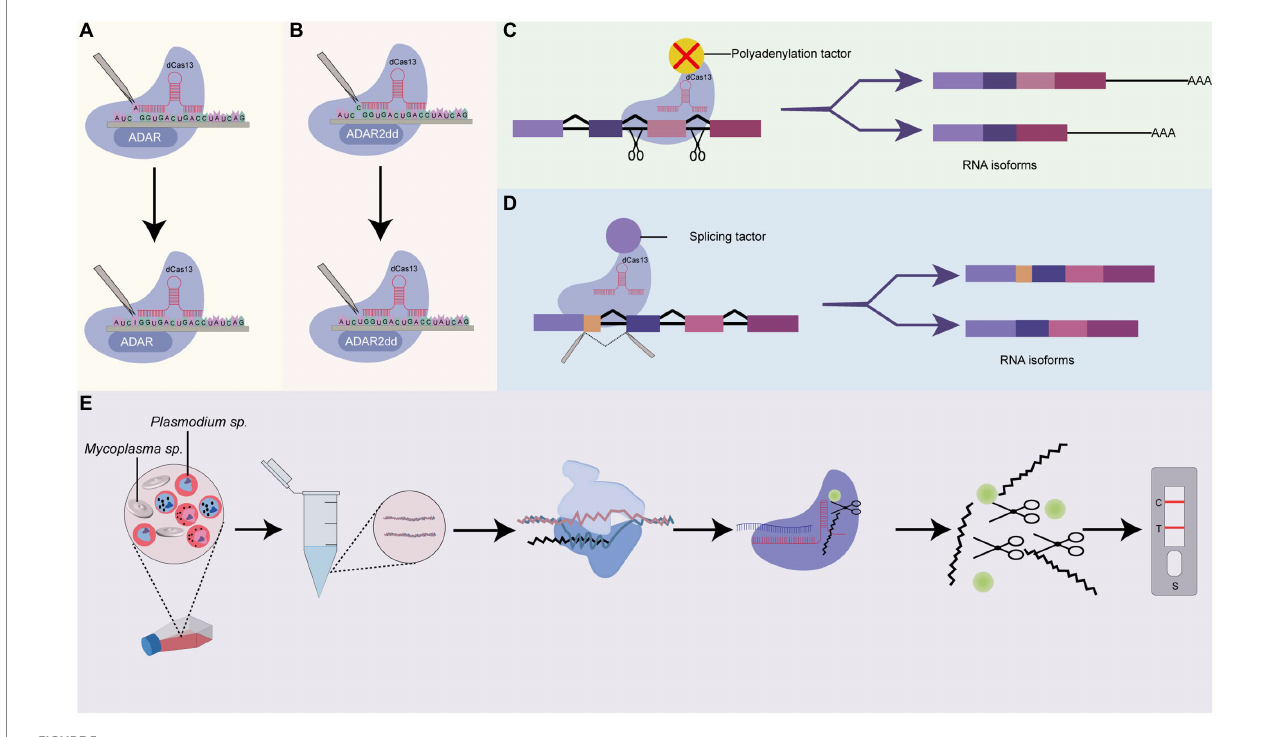
FIGURE 5 Prospects of Cas13-base systems for RNA editing in Plasmodium . (A) dCas13 tethered to ADARs for a single-nucleotide base editing in RNA. This system uses dCas13 effector-deaminase acting on RNAs (ADARs) domains fusion, for crRNA-guided programmable adenosine to inosine RNA editing, (B) dCas13 tethered to ADAR2dds for a single-nucleotide base editing in RNA. The dCas13 effector is fused with deaminase acting on RNA2 (ADAR2dd) for programmable Cytosine to Uracil RNA editing, (C) dCas13 tethered to a polyadenylation site or a polyadenylation factor. This system uses a dCas13 effector fused with an alternative splicing factor or AAUAAA polyadenylation sites to block access by the polyadenylation machinery. Depending on the positions of the polyadenylation site, it could be used to include or exclude specific exons during pre-mRNA processing, (D) dCas13 tethered to a splicing factor. This system could be used to characterize the functions of RNA isoforms of a specific gene, and (E) Cas13 system for rapid detection of Mycoplasma sp. as a contaminant in Plasmodium culture. CRISPR-Cas13 can be used to target Mycoplasma sp. AfterT7 transcription and amplification of target Mycoplasma sp. RNA, the transcript is subjected to CRISPR-Cas13 detection. The binding of crRNA to the target RNA activates the solvent-exposed HEPN site for non- specific cleavage of nearby RNA-linked reporters to emit a signal. The resulting signal could be measured using lateral flow detection with antigen-labeled